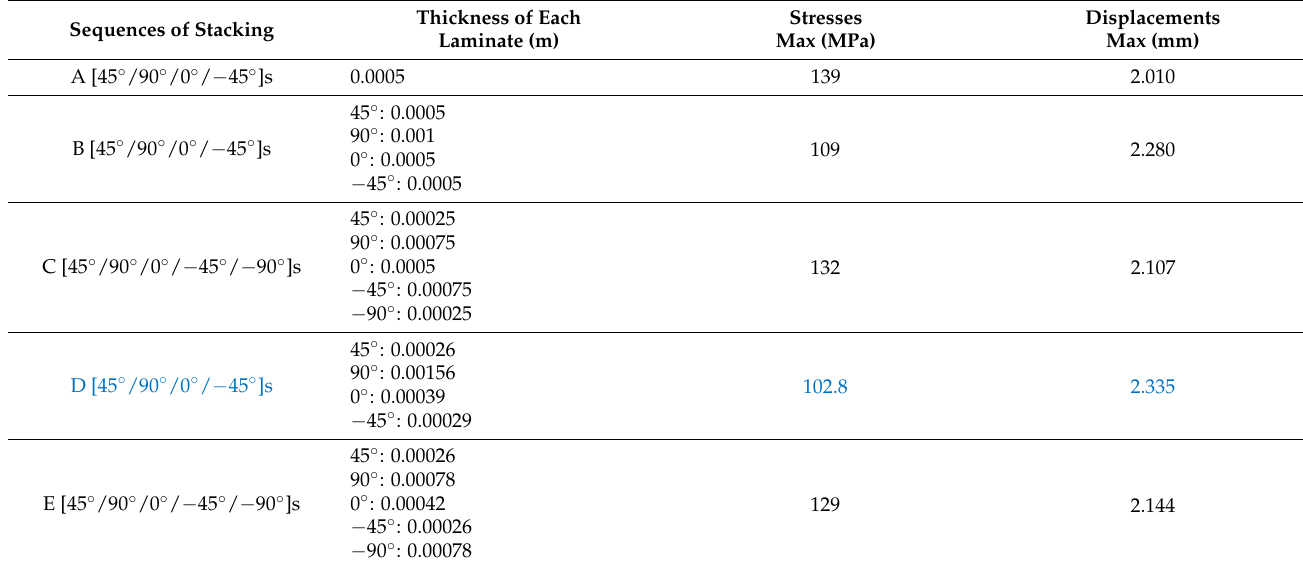
Table 8. Different combinations of glass–epoxy laminates and comparison of results with aluminum ( S max = 186.581 MPa, U max = 3.150